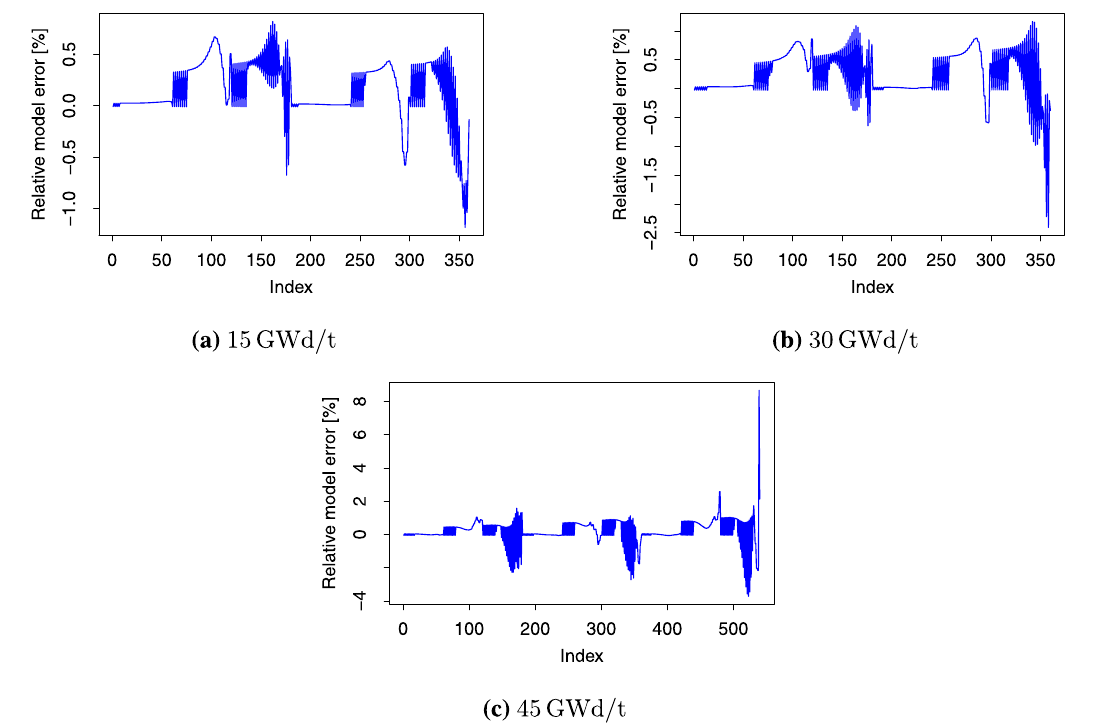
Fig. 9. H gap model calibration errors for the different assembly clusters where index is the label of the data used for the